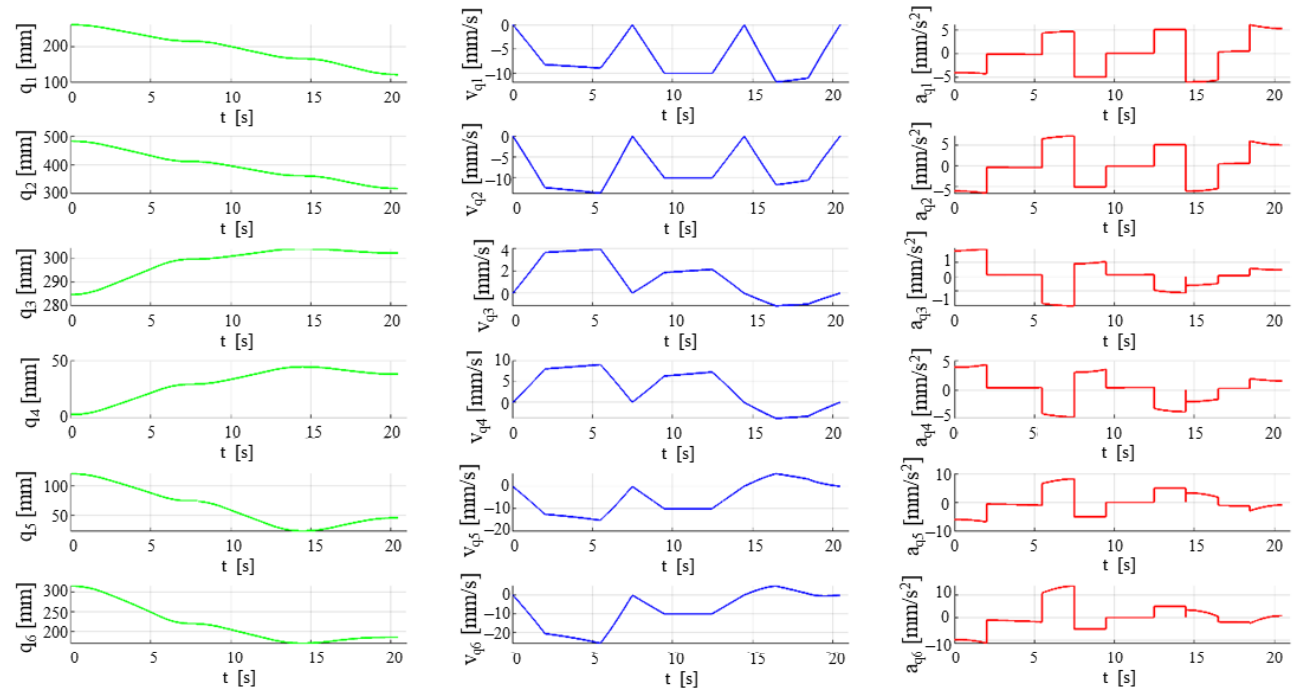
Figure 24. Time history diagrams of the active joints (position — green, velocity — blue, accelera- tions — red).